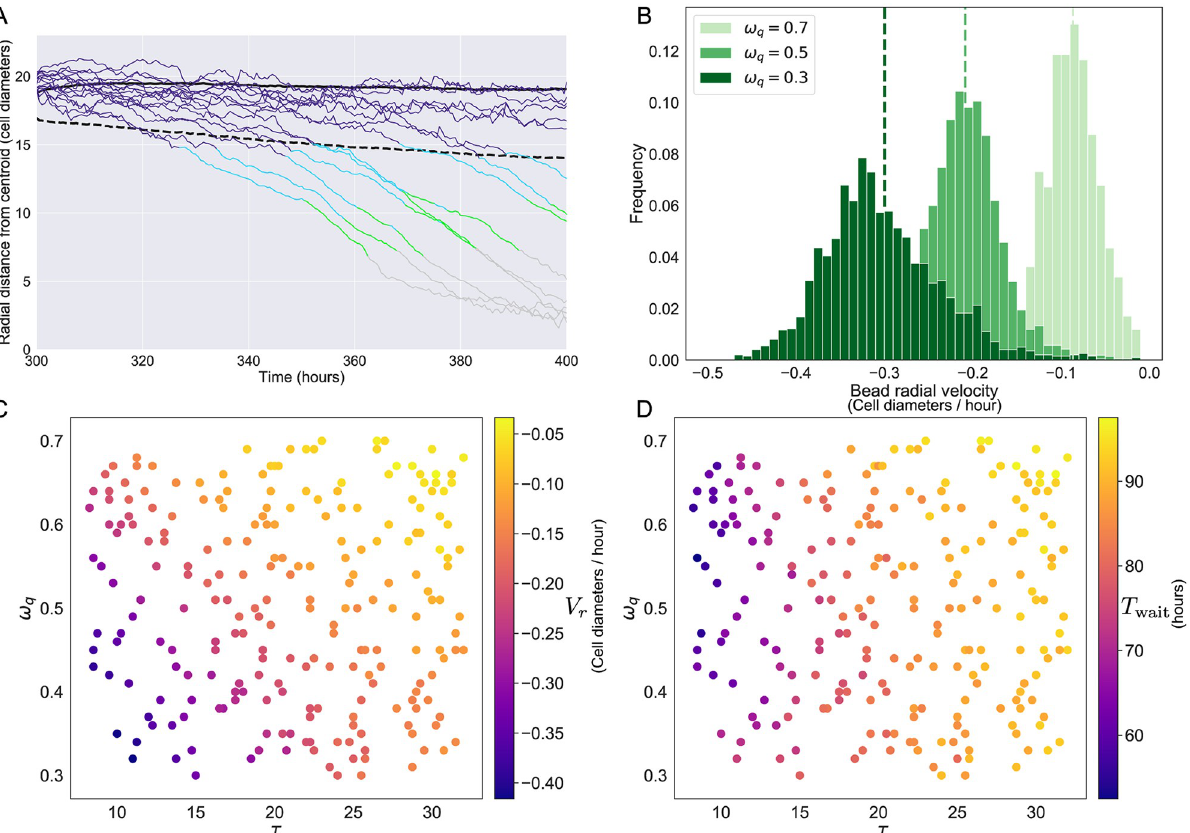
Fig 5. The radial trajectory of individual microbeads correlates with simulation parameters. A: Radial trajectories of 15 beads infiltrating a tumour spheroid (parameters ω q = 0.5, ω h = 0.3, τ = 16, ~ t ¼ 8 ). Solid black line: approximate radius of tumour spheroid; dashed black line: threshold between regimes based on estimated microbead Brownian motion coefficient D est ( Threshold ¼ 0 : 9 � Spheroidradius (cid:0) Trajectories are coloured according to the oxygen concentration at the microbead location. We distinguish two phases of infiltration: beads which have not crossed the dashed threshold appear to move by Brownian motion, while those which have crossed the threshold move predominantly by advection. B: Average radial velocity (cell diameters per hour) of infiltrating microbeads within 50 repeats of a representative parameter set for three values of ω q (parameters ω h = 0.3, τ = 16, ~ t ¼ 8 ). Dashed vertical lines show the mean radial velocity for each distribution. C and D: Plots showing how the average radial velocity V r and the waiting time T wait change as τ and ω q vary, for fixed ω h = 0.3 and ~ t ¼ 8